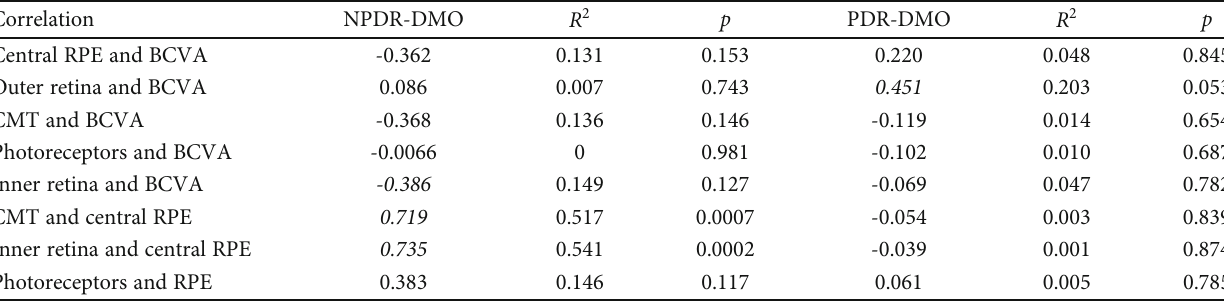
Table 4: Correlations between BCVA and retinal layers